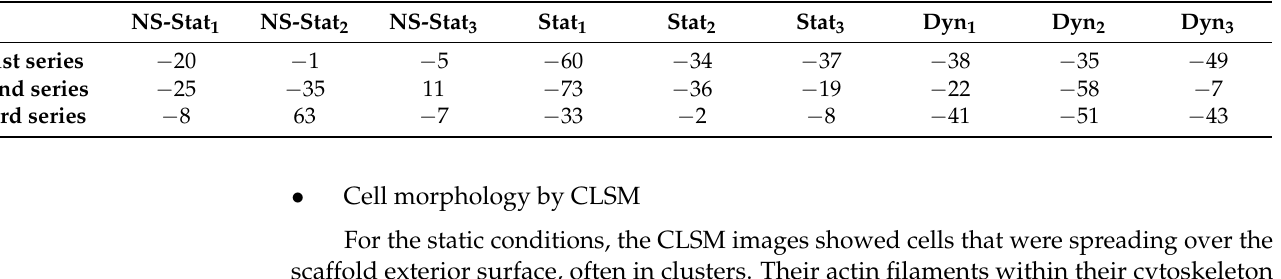
the scaffold exterior surface, often in clusters. Their actin filaments within their cytoskel- eton (green) were well organized (Figure 5 left). Conversely, few nuclei with only a little actin expression were observed on the dynamic scaffold surfaces (Figure 5 right).